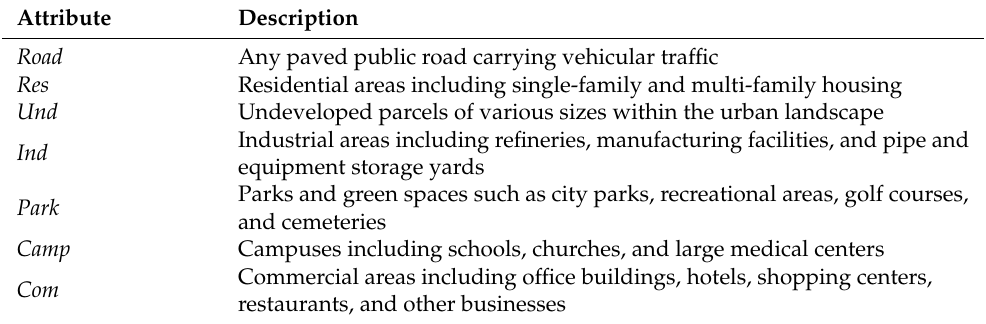
Table 1. Urban landscape attributes quantified in 1 km 2 grid cells surveyed annually for San Joaquin kit foxes and red foxes in Bakersfield, California, United States, from 2015 to 2019. Attribute Description